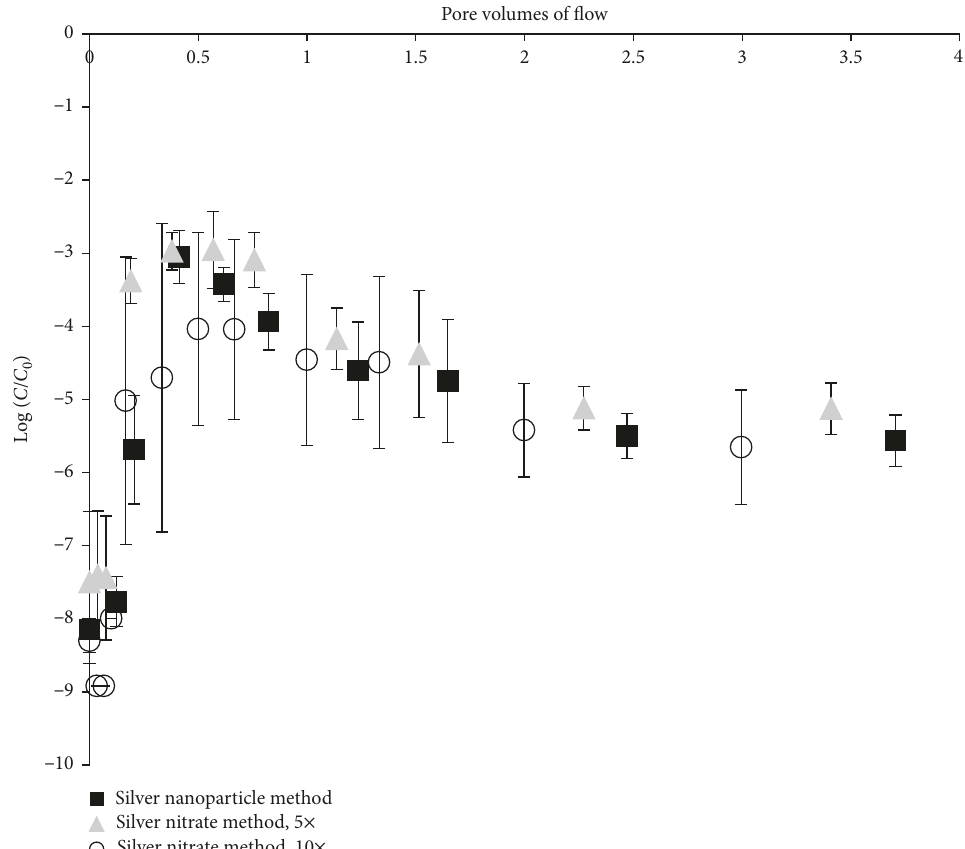
Figure 3: Average log change of E. coli , log( C / C 0 ), versus pore volumes of flow after an one-min pulse injection of E. coli to ceramic filters manufactured using the silver nanoparticle method and the silver nitrate application method. Error bars show one standard error above and below the mean. For the silver nitrate application method, the mass of added silver was five times (5x) or ten times (10x) the mass of silver applied to the ceramic filter fabricated using the silver nanoparticle method. Samples were taken at the same time for each disk and converted to pore volume. Since pore volumes varied minimally (3%) between disks, samples at the same time were